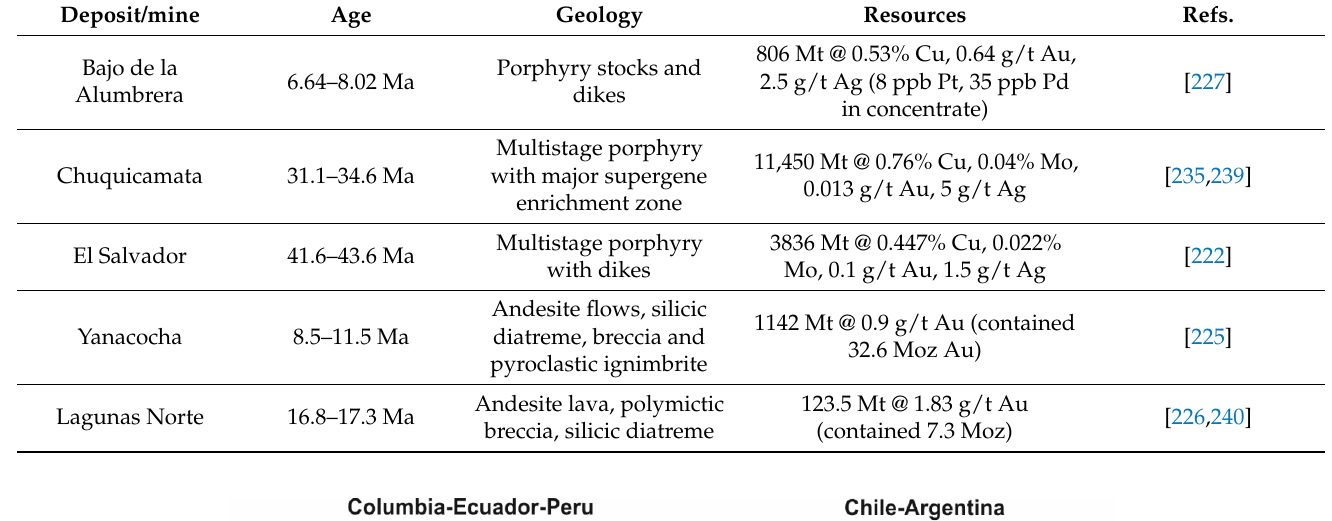
Table 9. Main characteristics of selected adakite-hosted Cu–Au deposits in the Andes.